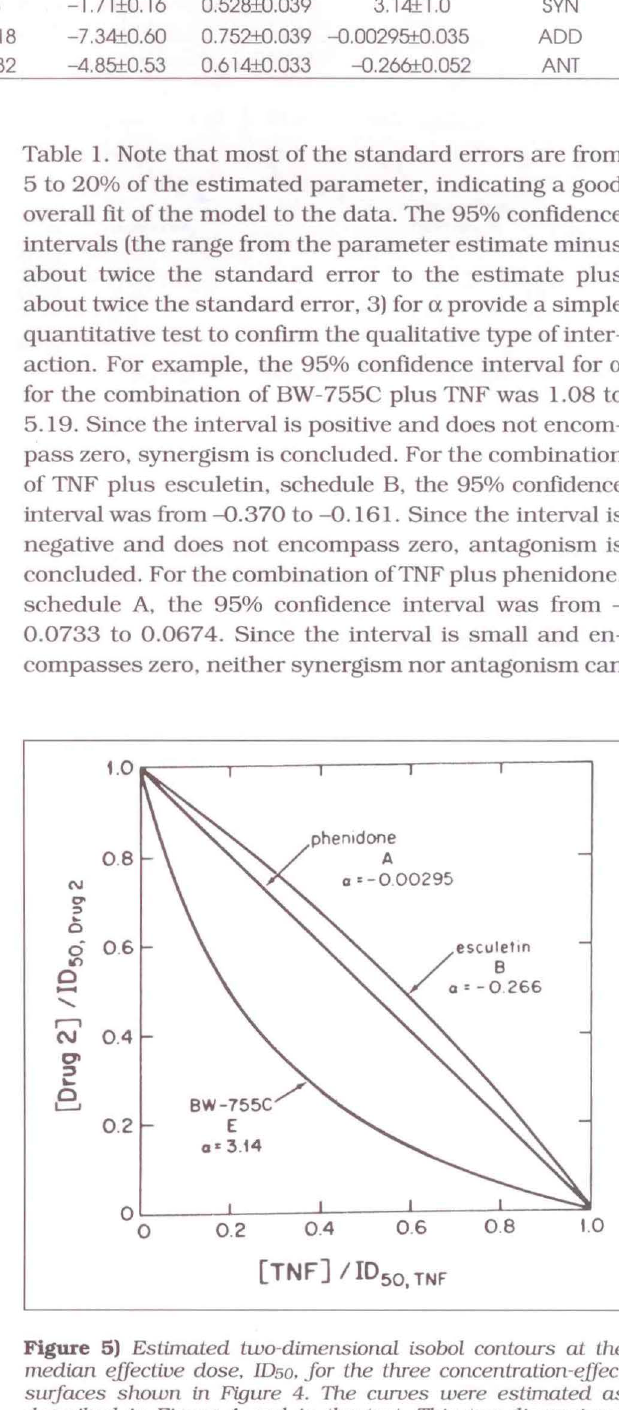
Second drug Schedule DmrNF (U/ml)